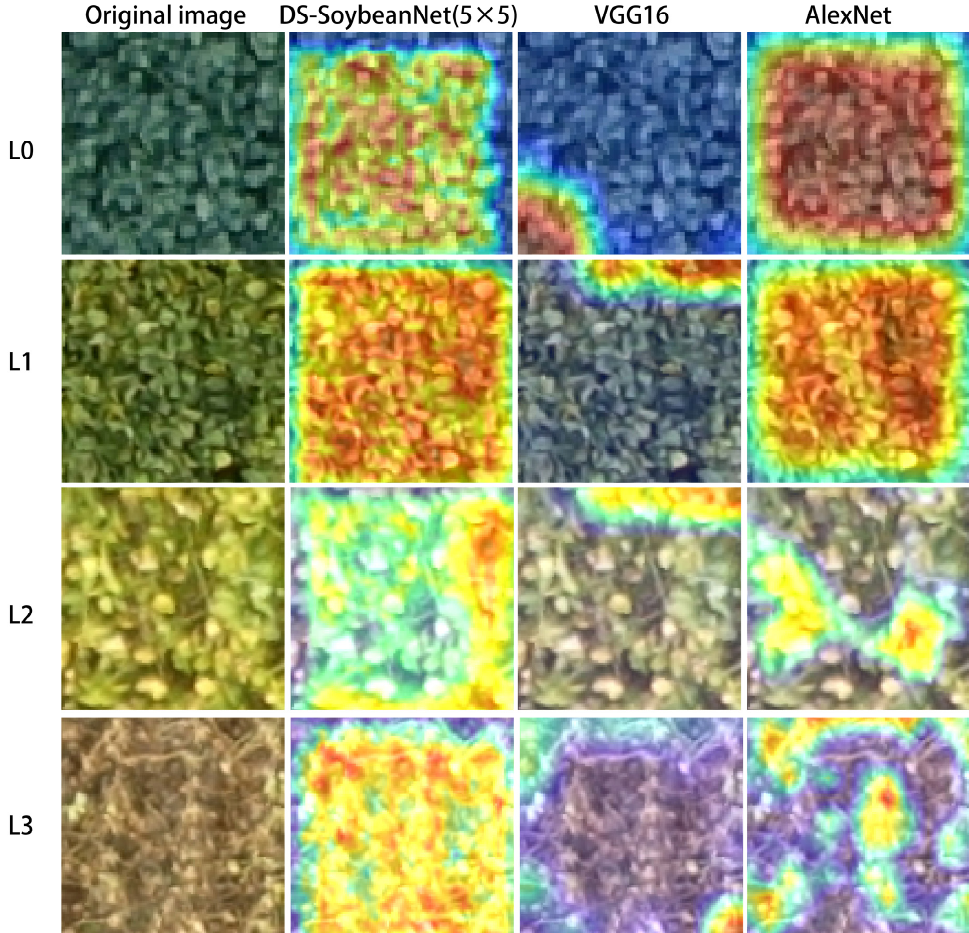
Figure A1. The attention regions of the top 3 (Table 9) models in soybean canopy images. Table A1. Details of the proposed DS-SoybeanNet with 5 × 5 kernels.